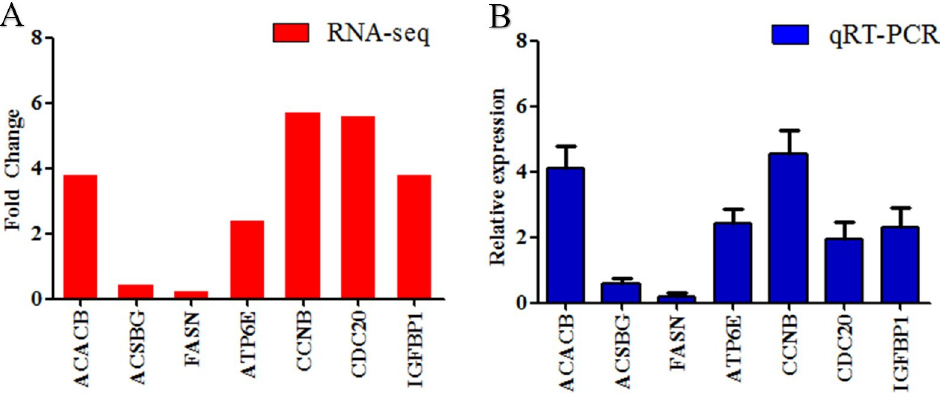
Fig 6. Validation of RNA-seq data by qRT-PCR. (A) The RNA-seq data. (B) The qRT-PCR data. The values are the ratio of gene expression levels in the fast-growth group to those in the slow-growth group by the two methods.